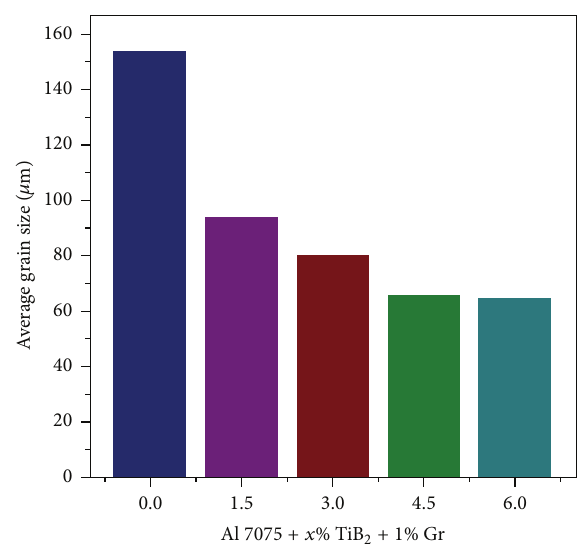
Figure 6: Grain size of Al 7075/ 𝑥 % TiB 2 /1% Gr hybrid composites.